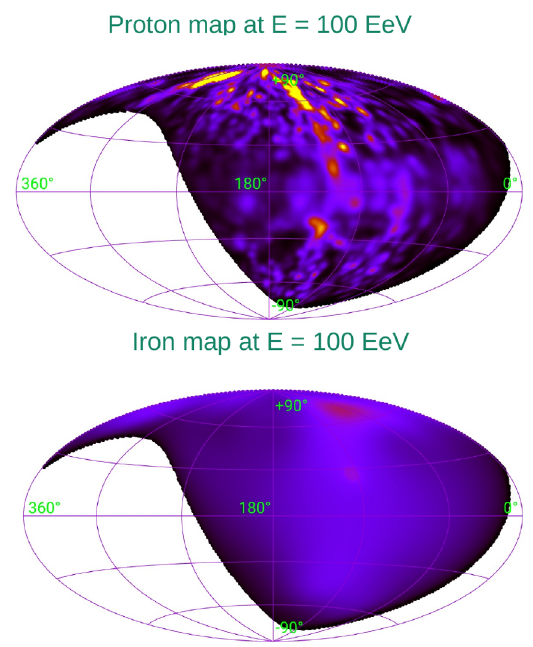
Figure 1. Examples of flux maps used for mock UHECR sets